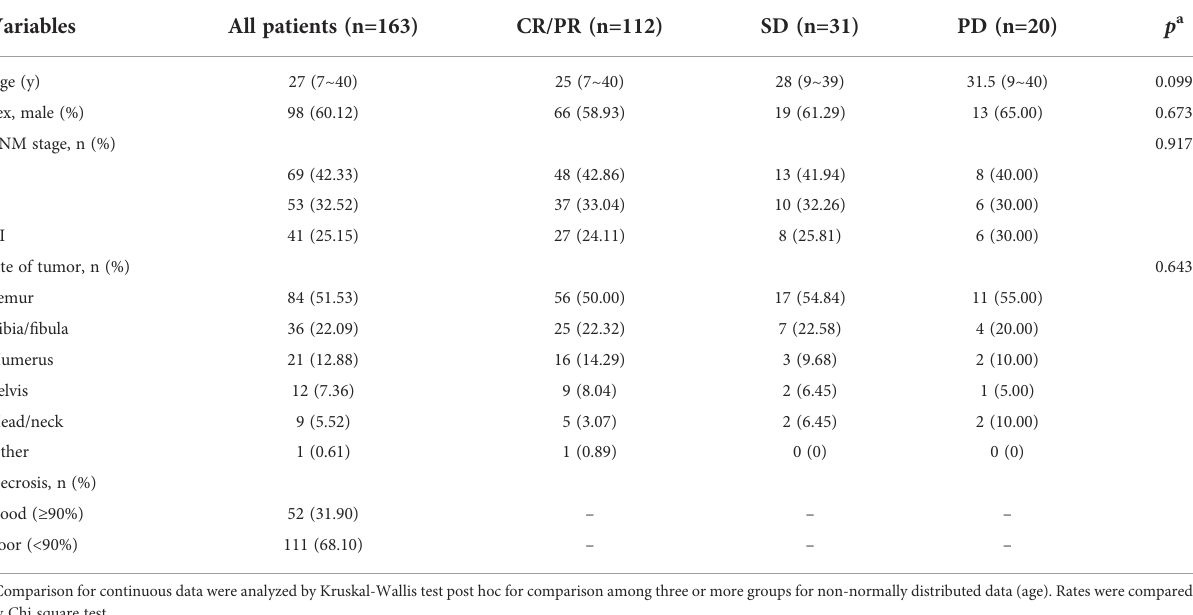
TABLE 1 Basic clinical characteristics of all patients.